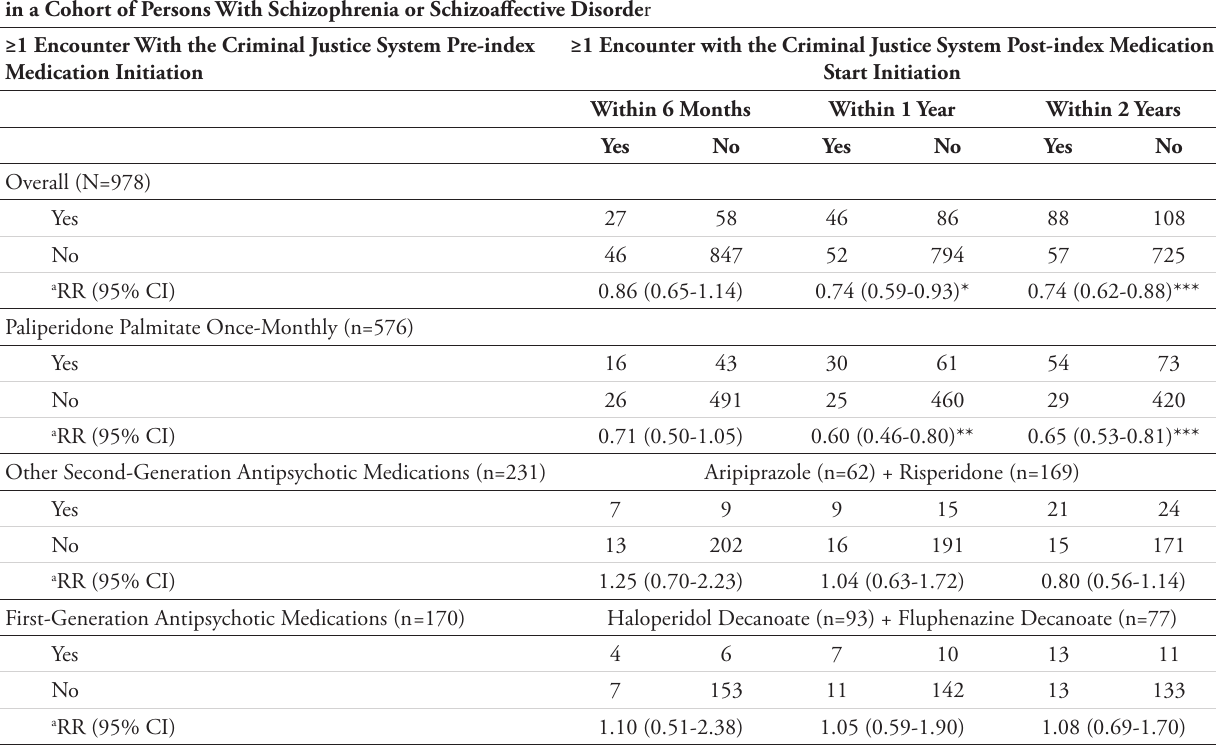
Table 3. Comparison of the Risk of Encounters with the Criminal Justice System After Initiating Index LAI Antipsychotic Treatment in a Cohort of Persons With Schizophrenia or Schizoaffective Disorde r ≥1 Encounter With the Criminal Justice System Pre-index Medication